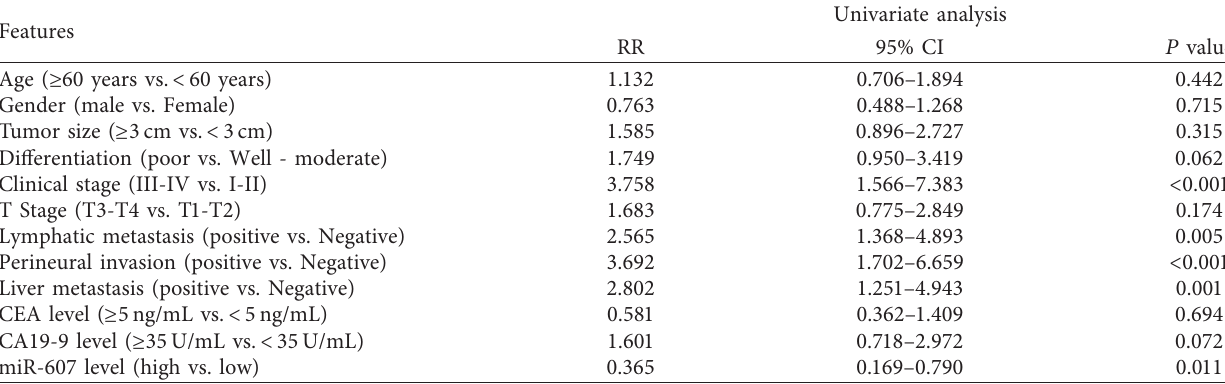
Table 2: Univariate Cox regression analysis of different prognostic factors for OS in PDAC patients.